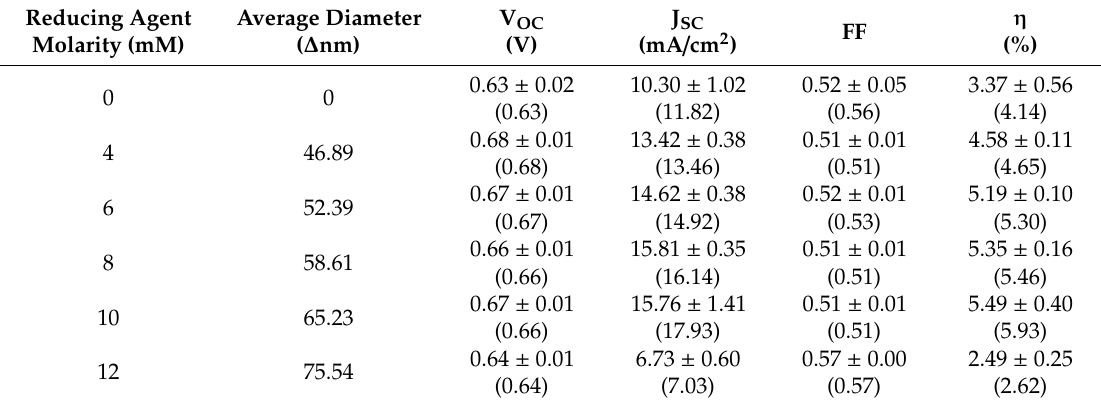
Table 2. Photovoltaics parameter of DSSC for different sodium citrate concentration.